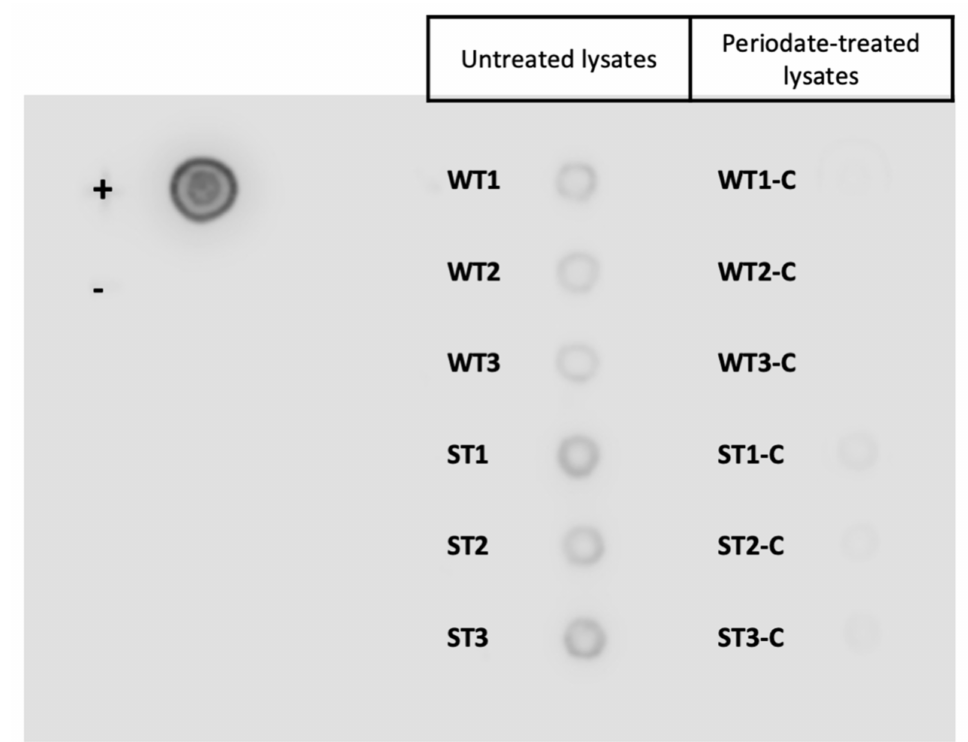
Figure 2. Confirmation of disruption of glycan structures by sodium periodate. ConA lectin dot blot confirming successful disruption of glycan structures after treatment of sheep abomasal whole tissue (WT) and scrape tissue (ST) with 20 mM sodium periodate. Approximately 20 µ L of each sample was dotted onto a polyvinylidene difluoride (PVDF) membrane and probed with horseradish peroxidase conjugated Concanavalin A (ConA-HRP) lectin. (WT1-3) Biological replicates of abomasal whole tissue extracts. (ST1-3) Biological replicates of abomasal scrape extracts. ( − C) Periodate-treated negative control samples. (+) Fasciola hepatica whole worm extract used as a positive control. ( − ) Periodate treated Fasciola hepatica whole worm extract used as negative